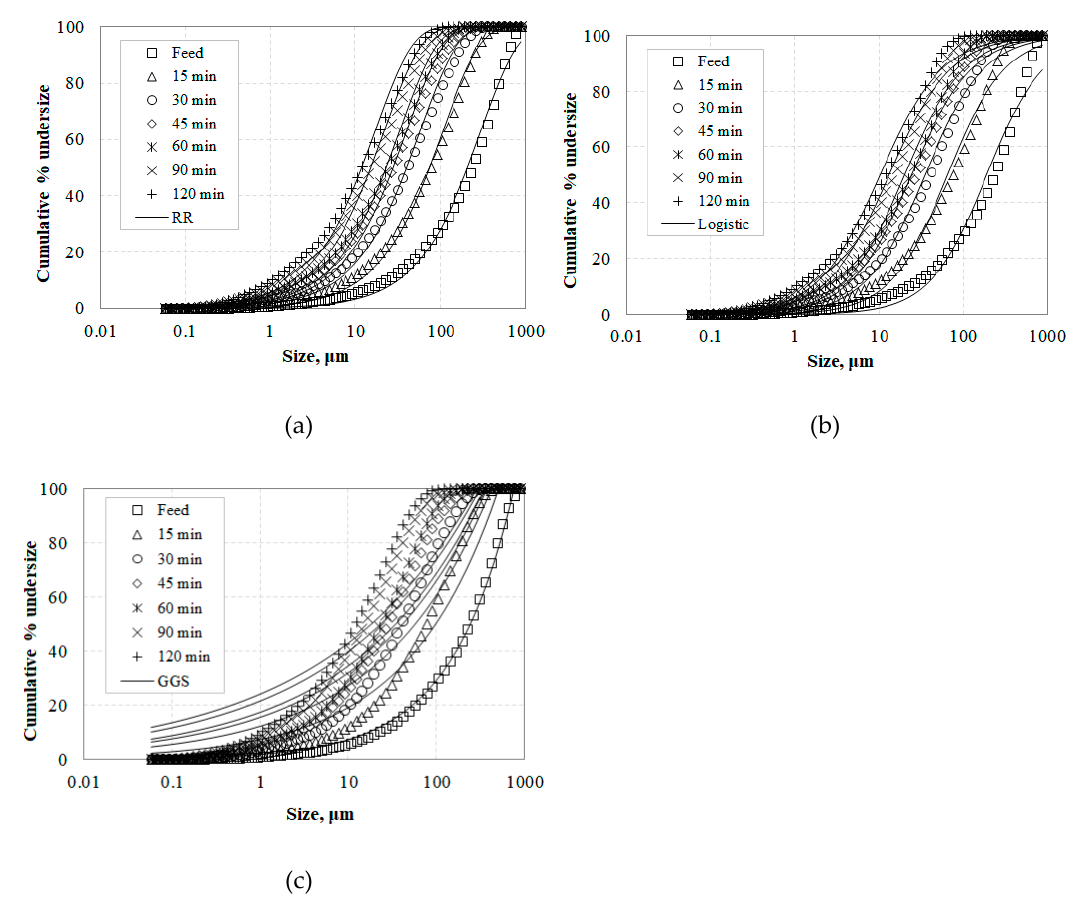
Figure 6. Particle size distribution of slag grinding products using the ( a ) Rosin–Rammler (RR) and ( b ) Logistic model, and ( c ) Gates–Gaudin–Schuhmann (GGS) distributions.